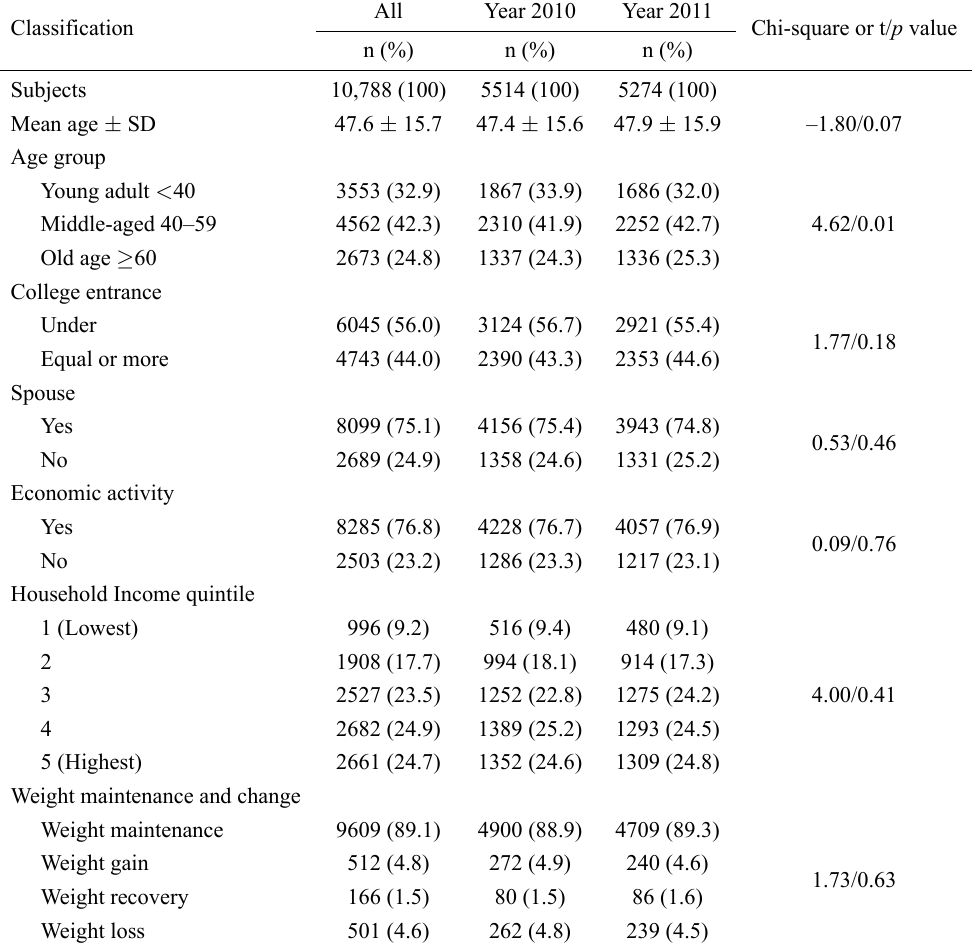
Table 1. Sociodemographic characteristics of male subjects by